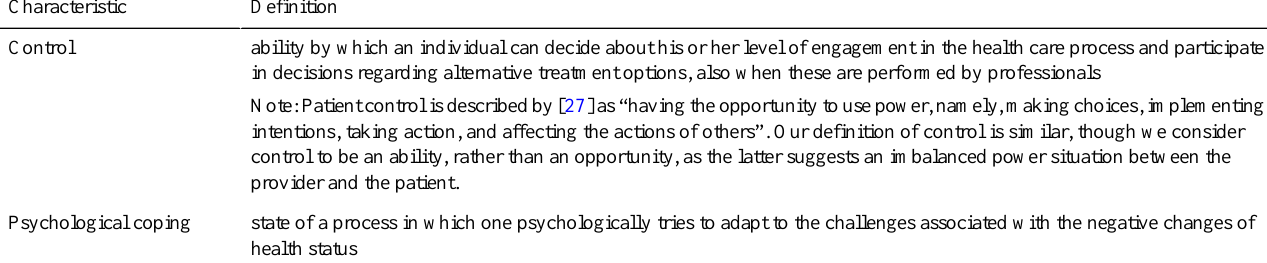
Table 1. Characteristics of